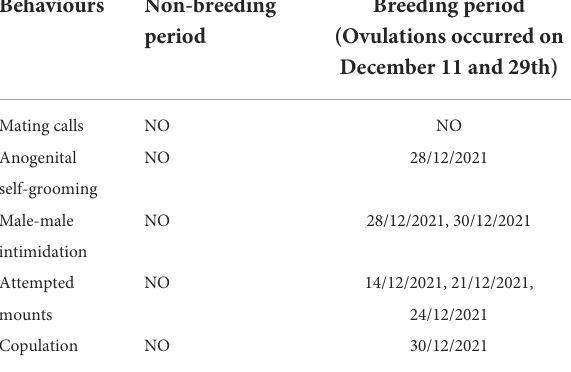
TABLE 5 Overview of the behavioural observations (NO,